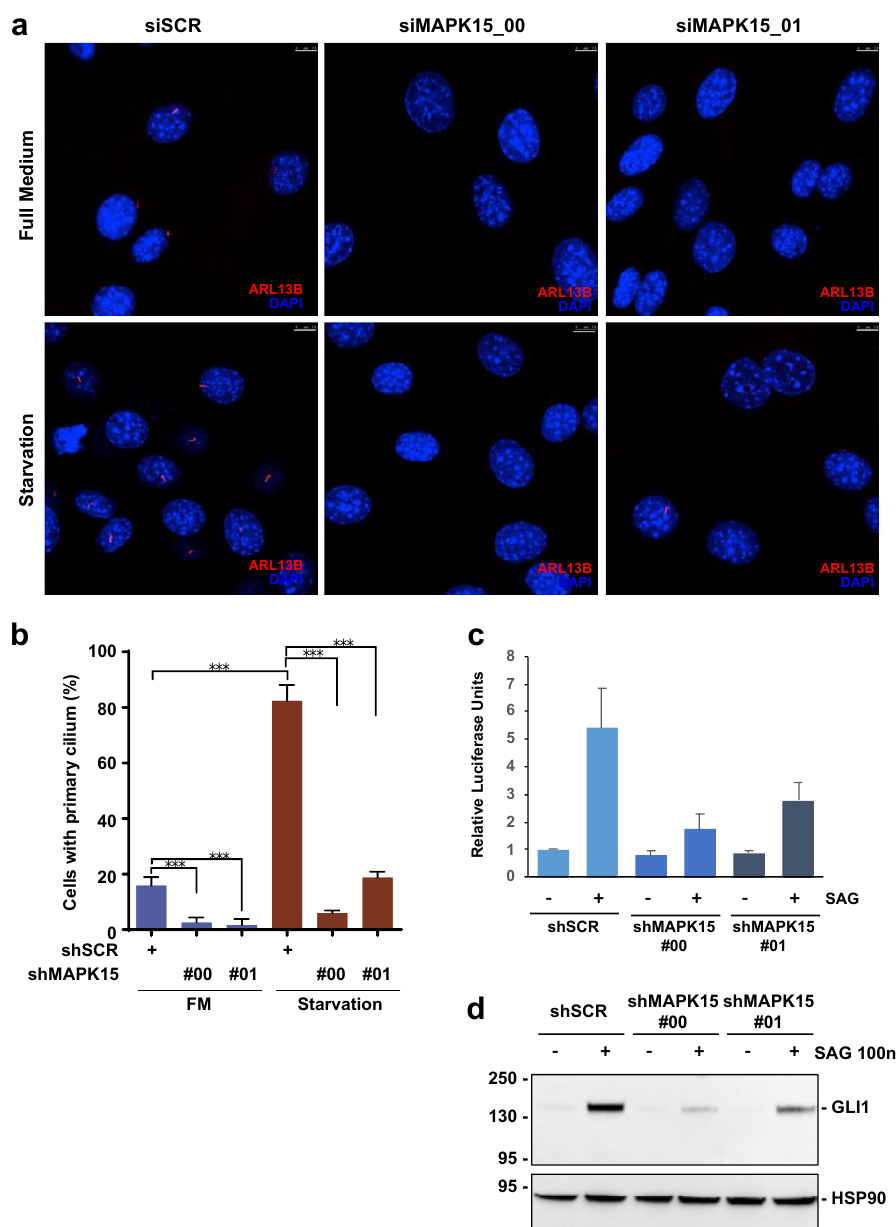
Figure 2. MAPK15 regulates the HH pathway in NIH3T3 cells. ( a ) NIH3T3 cells, stably transduced for scrambled (shSCR) or two different MAPK15 (shMAPK15)-specific shRNAs were incubated in full medium (FM) or starvation media for an additional 24 h. Cells were next fixed and subjected to immunofluorescence analysis. In these representative images, ARL13B is visualized in red and nuclei in blue (DAPI). Scale bars correspond to 7.5 μm. Percentage of primary cilium-positive cell was plotted on the accompanying graph ( b ). ( c ) Quantification of GLI-dependent luciferase reporter assay in HH-responsive NIH3T3 cells stably transduced for shSCR, shMAPK15_#00, or shMAPK15_#01 and treated with 100 nM SAG for 48 h. Relative luciferase units were GLI-dependent reporter firefly/renilla control ratios, with untreated cells equated to 1. ( d ) Western blot of endogenous Gli1 protein in NIH3T3 cells transduced as indicated and treated with 100 nM SAG for 48 h. HSP90 was used as loading control. ***, p < 0.001. The uncropped blots are shown in supplementary materials (Figure S6).